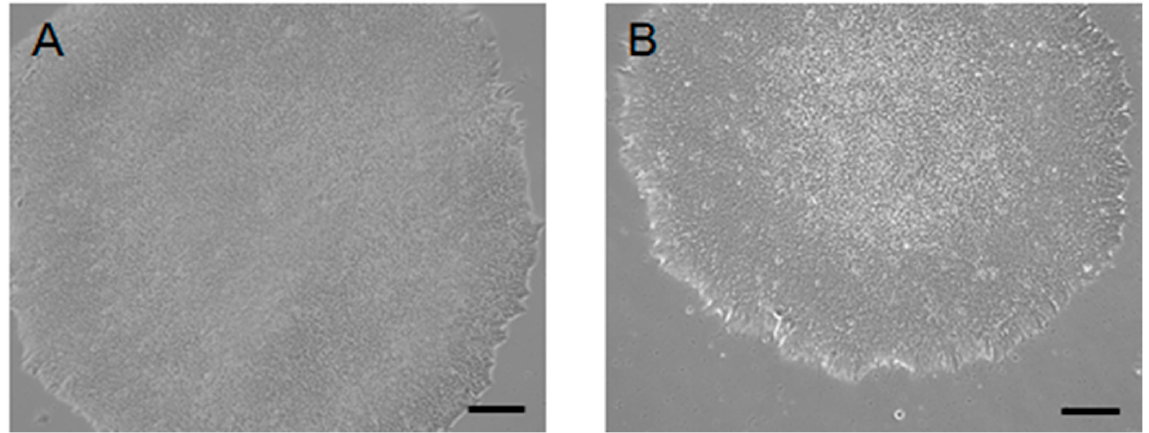
Figure 1. Morphological analysis of H9 hESCs after ten passages cultured in homemade E8 media under a feeder-free condition. The media contained either hFGF-2 ( A ) or hDJ-1 ( B ). Scale bars indicate 100 µm.